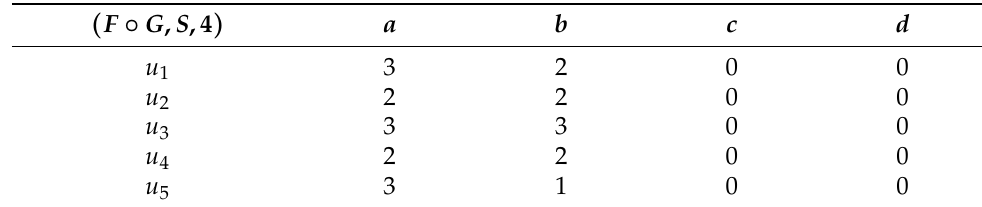
Table 12. The 4-Soft Set of ( G , S ,4 )